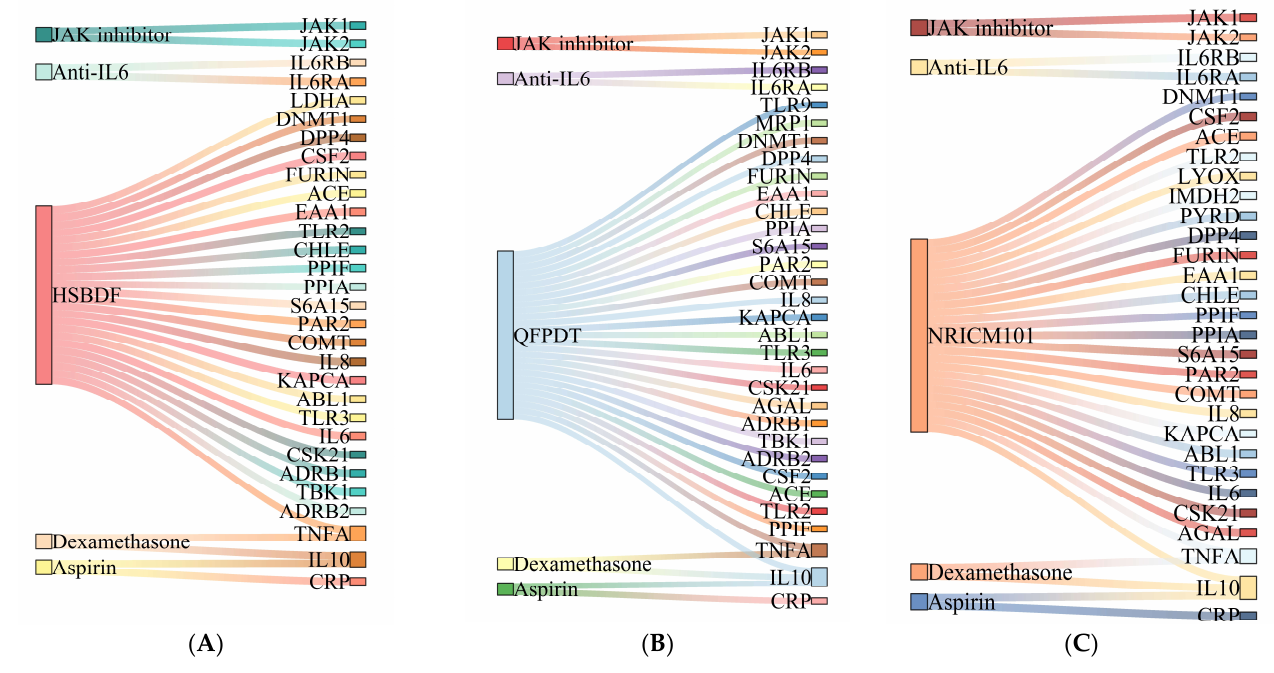
Figure 4. ( A ) Interaction between HSBDF plus WM and COVID-related proteins in a Sankey dia- gram. ( B ) Interaction between QFPDT plus WM and COVID-related proteins in a Sankey diagram. ( C ) Interaction between NRICM101 plus WM and COVID-related proteins in a Sankey diagram.